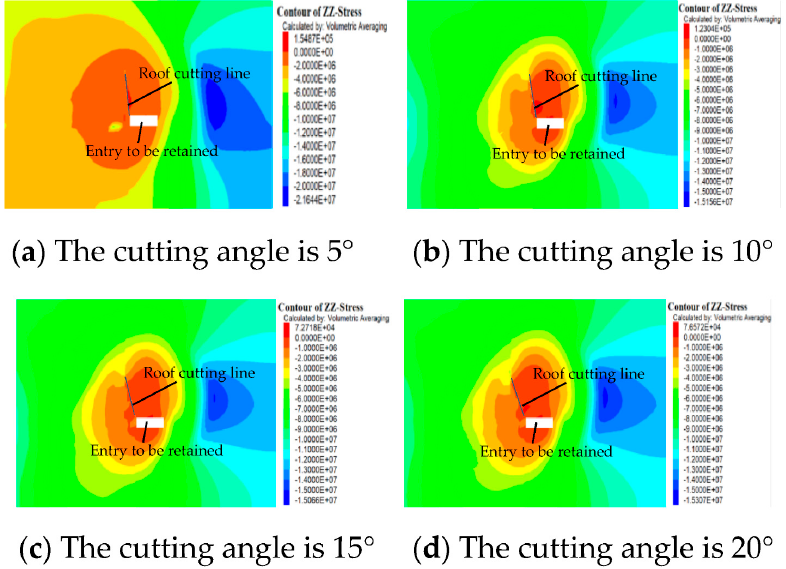
Figure 11. Vertical stress of roadway surrounding rock under different cutting